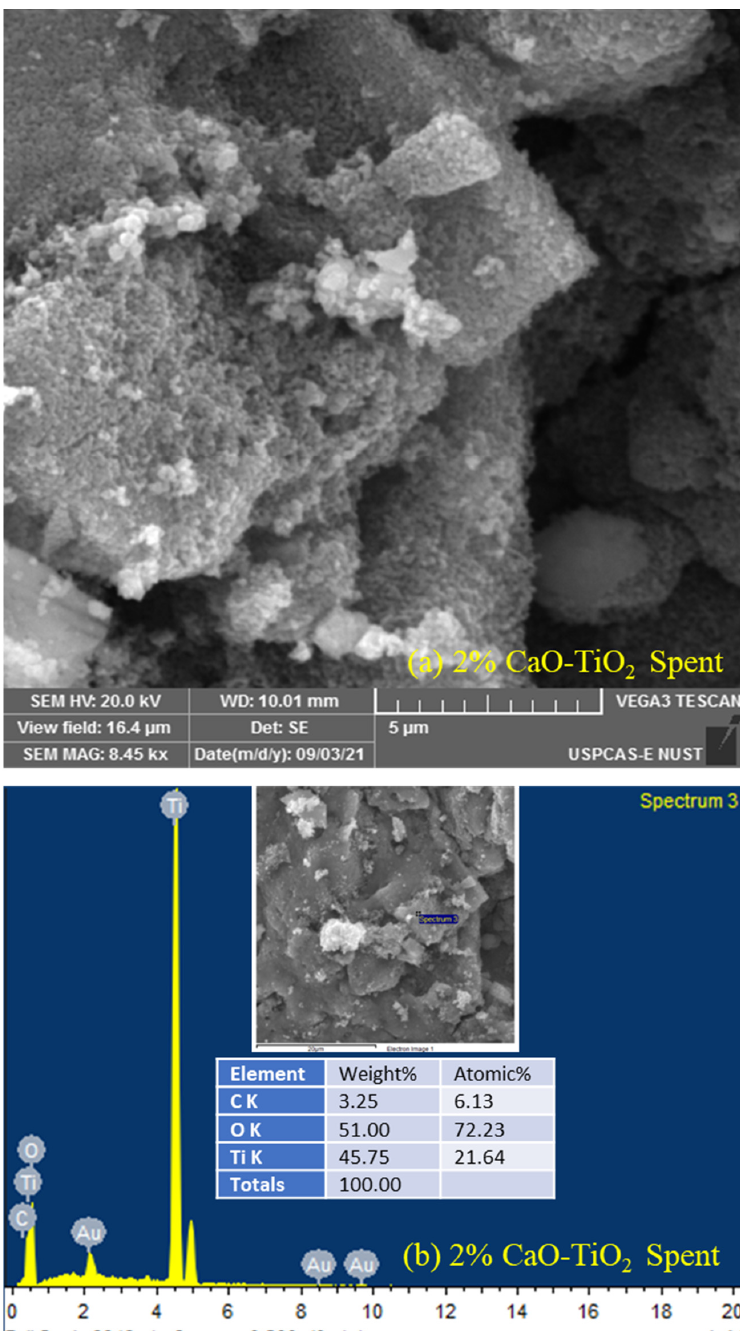
Figure 9. CaO loaded TiO 2 spent analysis ( a ) SEM ( b ) EDS analysis.